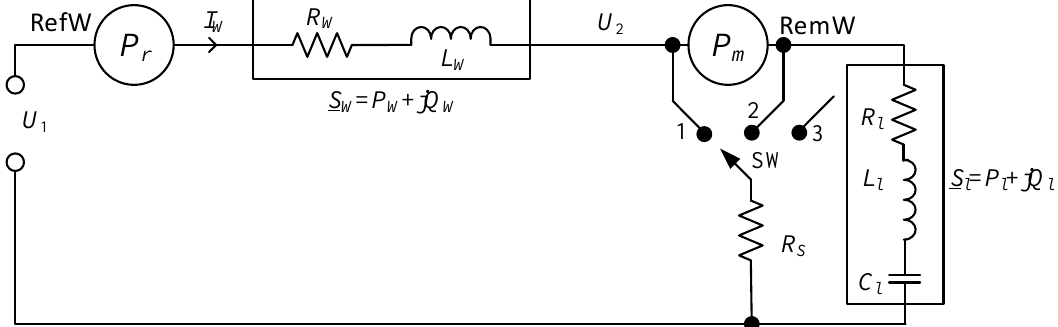
Figure 4. Reduced network model for the explanation of the analytical error expression derivation.